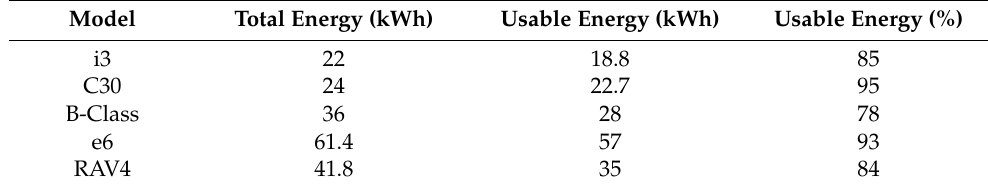
Table 10. Battery parameters of some current EVs. Data from